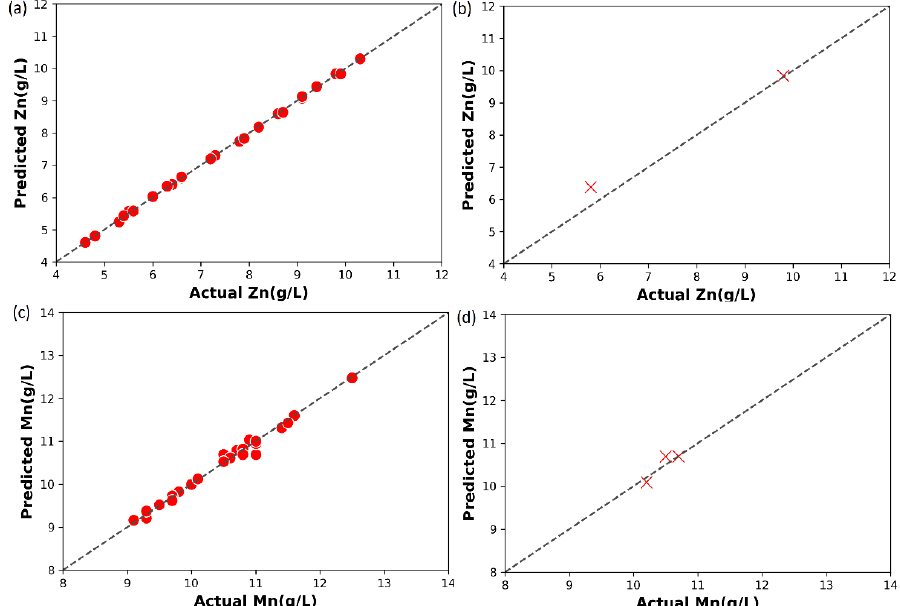
Figure 9. Actual versus gradient boosting regression-based predicted ( a ) Zn (g/L) training, ( b ) Zn (g/L) testing, ( c ) Mn (g/L) training and ( d ) Mn (g/L) testing data.